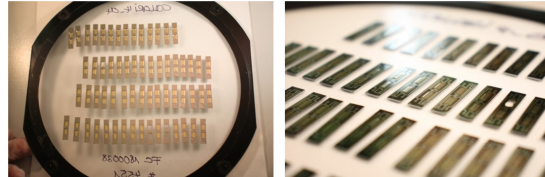
Figure 20. Prototype bolometer for ITER after receiving 10 thermal cycles at 400 ◦ C. Reprinted from Ref. [118]. Credit c (cid:13) Stefan Schmitt, Fraunhofer-IMM, 2020.